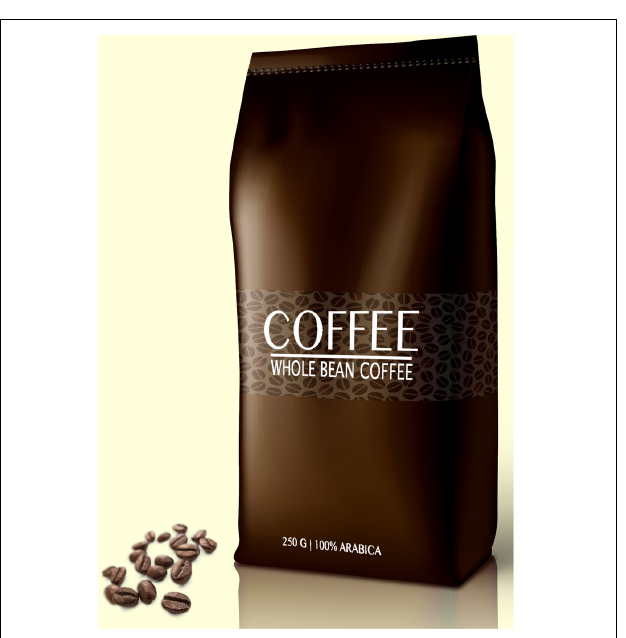
FIGURE 6 | No image, no text